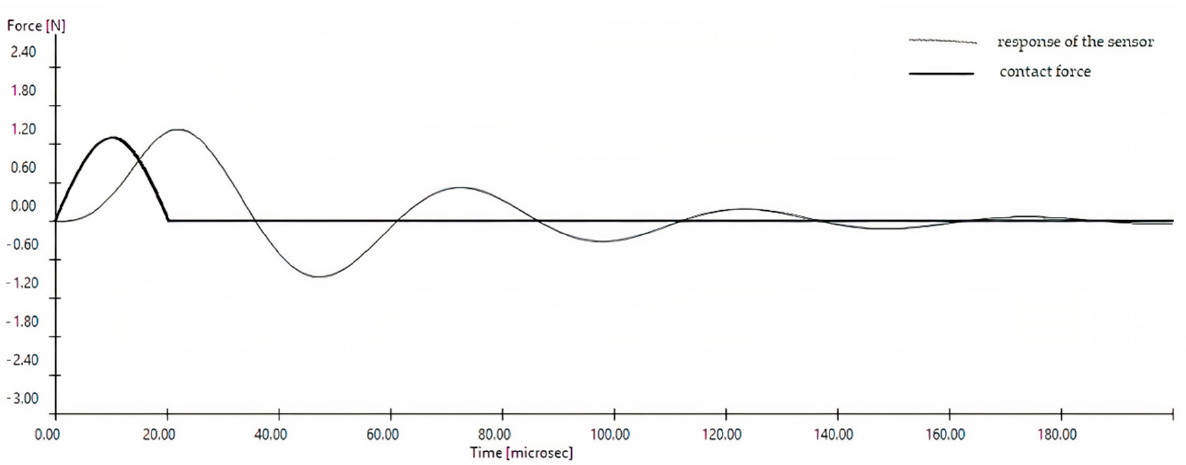
Figure 6. The course of the impact force and measurement signal from the sensor for a small dry grain. Contact stiffness k 2 = 1 × 10 5 Nm − 1 , f rez = 20 kHz.